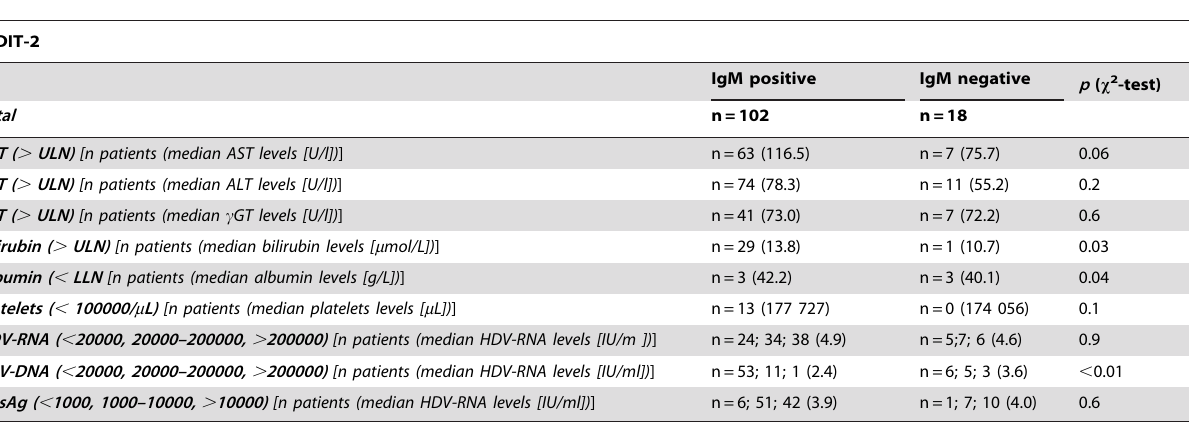
Table 2. Factors associated with anti-HDV IgM positive and negative values according to chi-square analysis in the HIDIT-2 cohort.